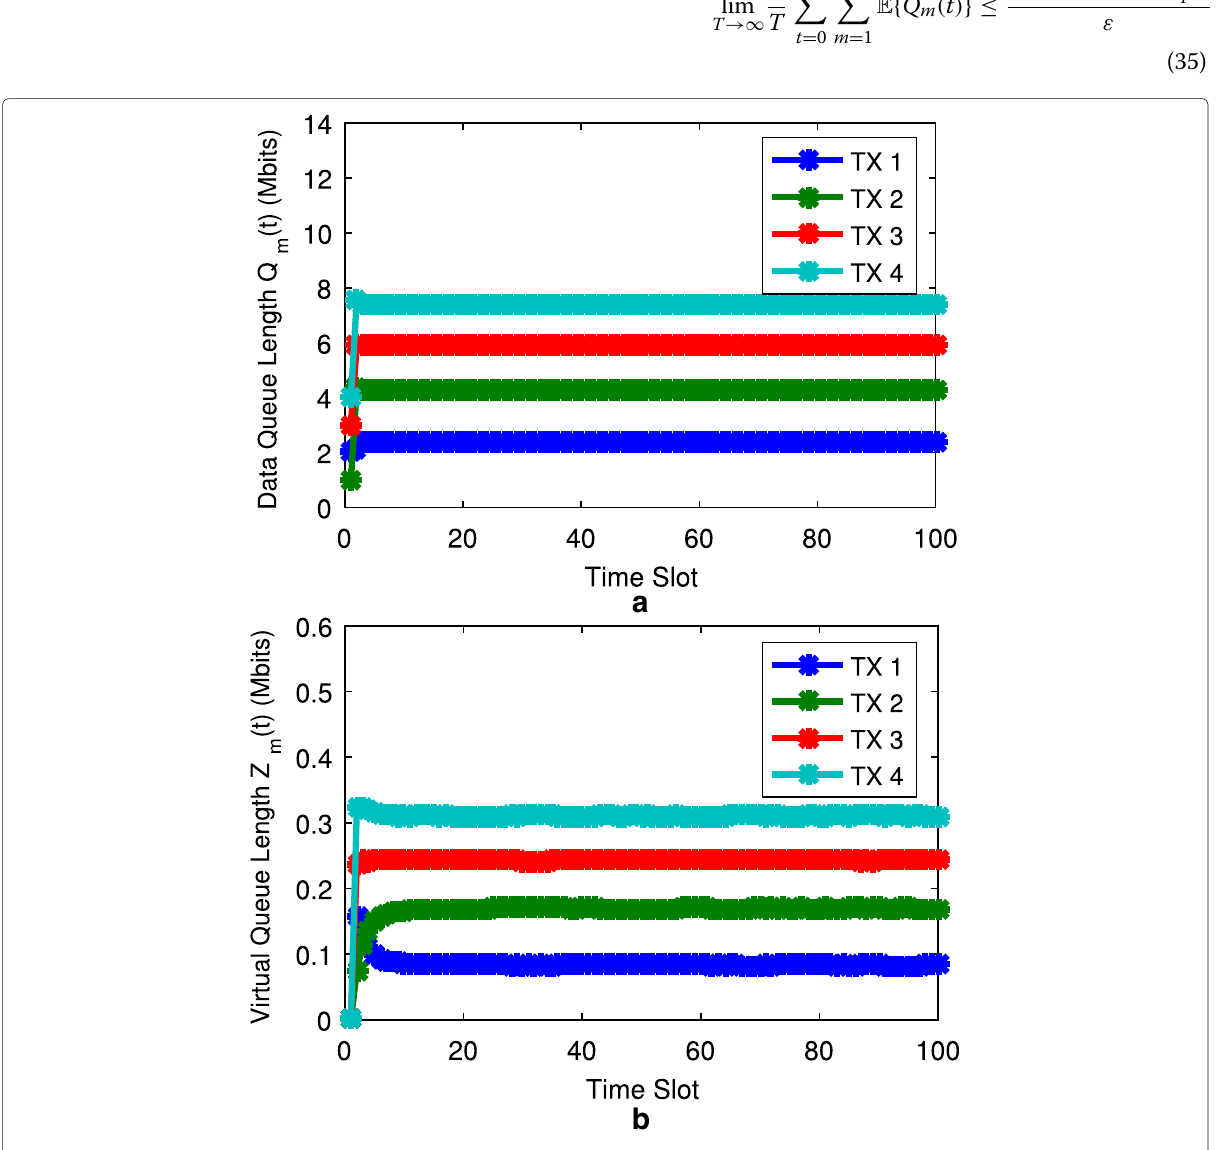
Fig. 2 a , b Queue stability versus time